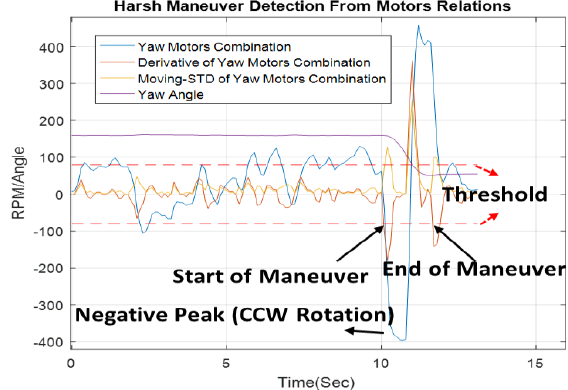
Figure 7. Harsh maneuver detection according to VM motors